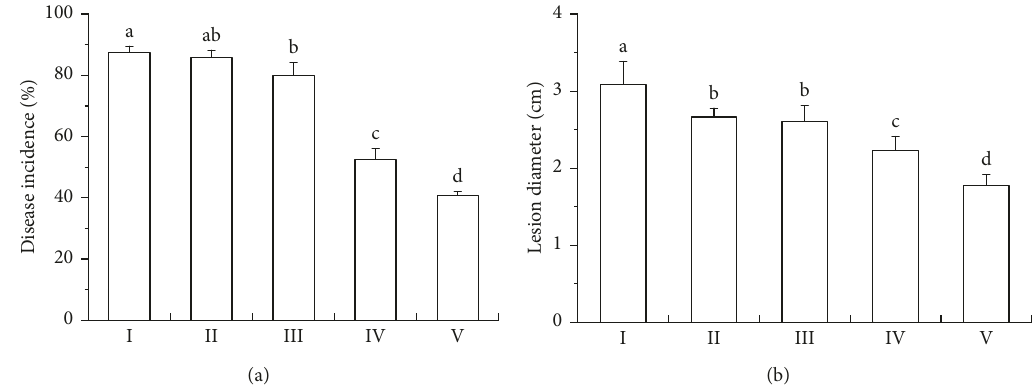
Figure 1: The effect of P. fluorescens on citrus for the control of P. digitatum : I, SDW; II, autoclaved cultures; III, culture filtrate; IV, 10 8 CFU/mL bacterial suspension. Columns with different lowercase letters within the same panel are 1 10 8 CFU/mL bacterial fluid; V, 1 × × significantly different at the P 0 . 05 level by Duncan’s multiple range <